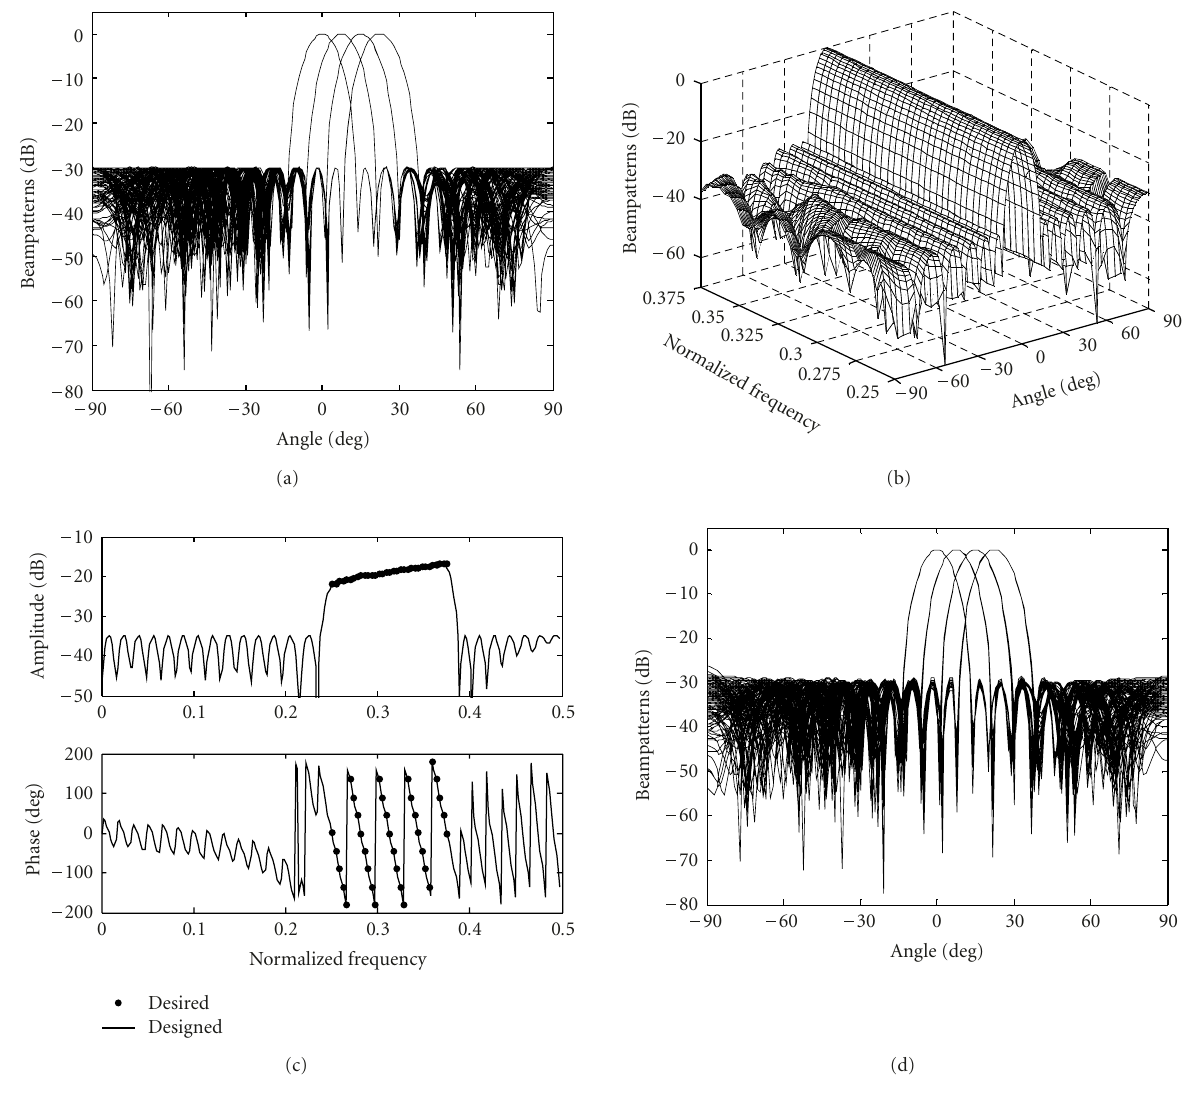
Figure 3: Design of the CMRBs. (a) Superposition of the beampatterns of frequency-domain CMRBs in K = 4 directions at J = 33 frequencies. (b) Variation of beampattern with frequency for the beamformer of 0 ◦ . (c) Frequency response of the FIR filter associated with the 5th sensor of the first beamformer. (d) Superposition of the beampatterns of time-domain CMRBs in K = 4 directions calculated at J = 33 frequencies.